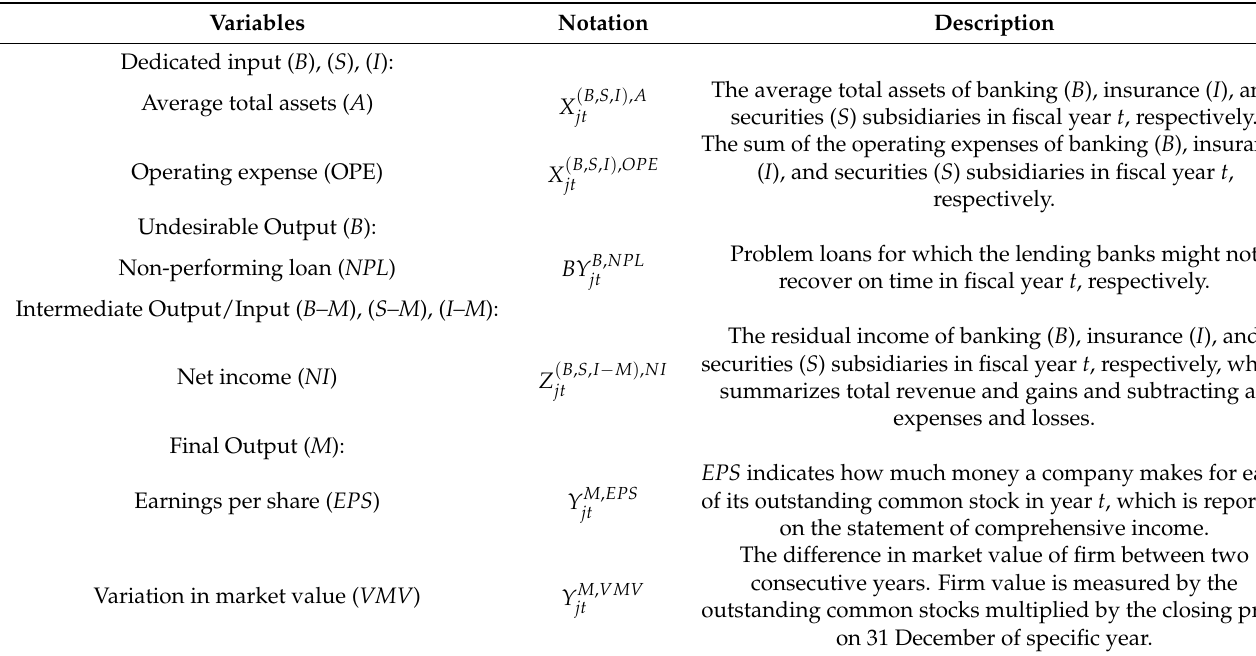
Table 1. Variables and